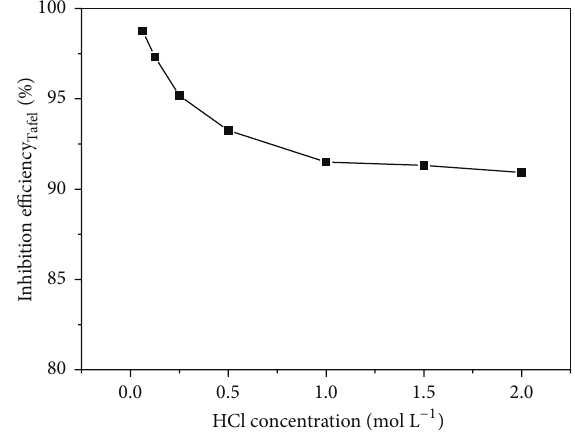
Figure 5: Relationships between inhibition efficiency and con- centration of HCl with 160mg L −1 EAPP from potentiodynamic polarization measurements for carbon steel at 300 K.